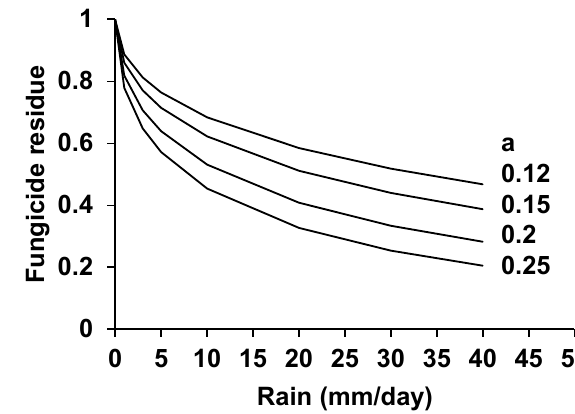
Figure 3. Changes in the proportion of fungicide residue re- maining as affected by rainfall, and as calculated by equa- tion C2 t = exp (- a × c t × √ R t ) [2]. “a” is the tenacity factor, which will differ among fungicides (the values in the figure are examples).